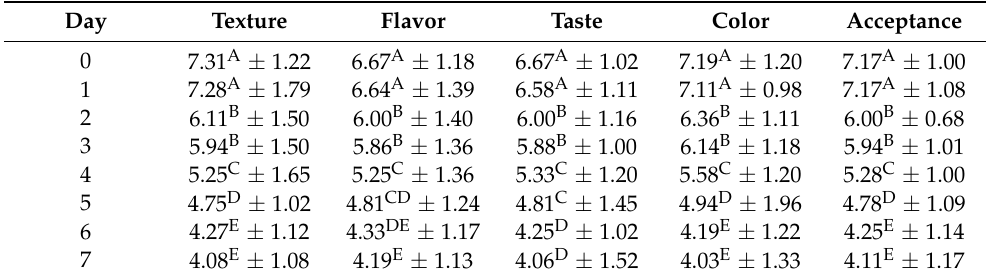
Table 2. Analysis of variance for the effect of storage time on the sensory evaluation of laban drink. Day Texture Flavor Taste Color Acceptance